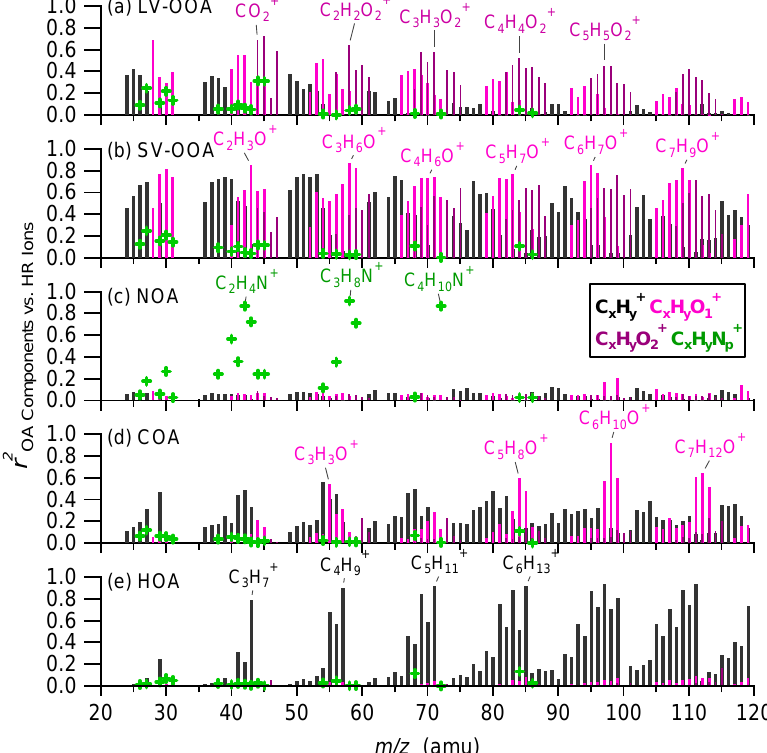
Fig. 9. Correlations of each OA component with the HRMS ions colored by four ion categories, i.e., C x H + y , C x H y O + C x H y N + p . The formulas of the ions that show significant correlations with individual OA components are marked.